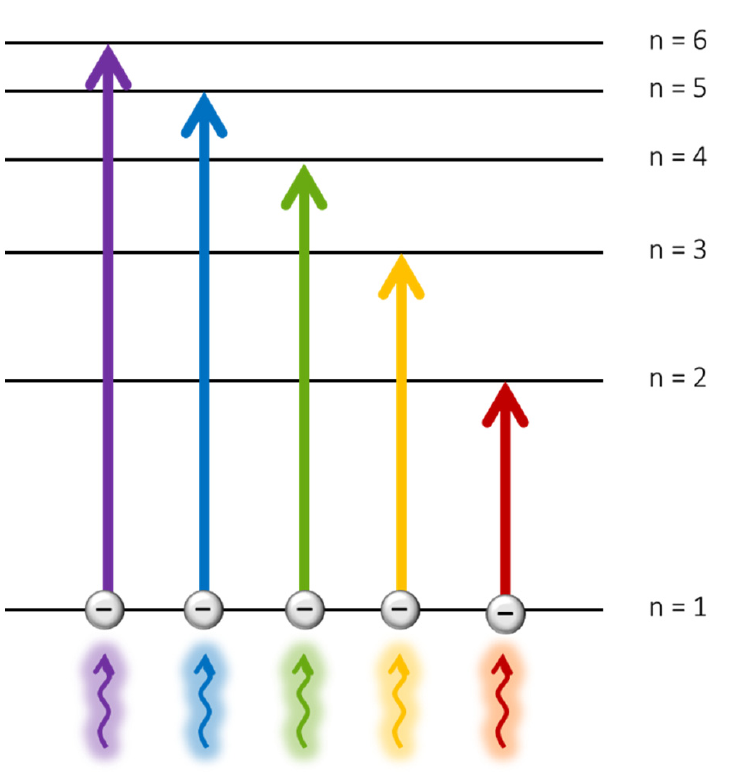
Figure 4. Schematic of an absorption-based technique. Incident photons promote electrons to higher level orbitals, leading to absorption/transmission phenomena as a function of the analyte increasing concentration.